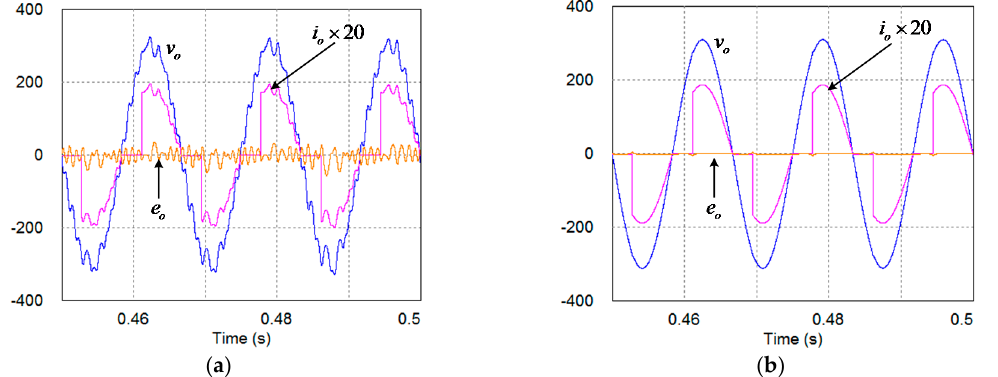
Figure 14. Zoomed in waveforms of the simulation results. ( a ) K d = 14; ( b ) K d = 35.